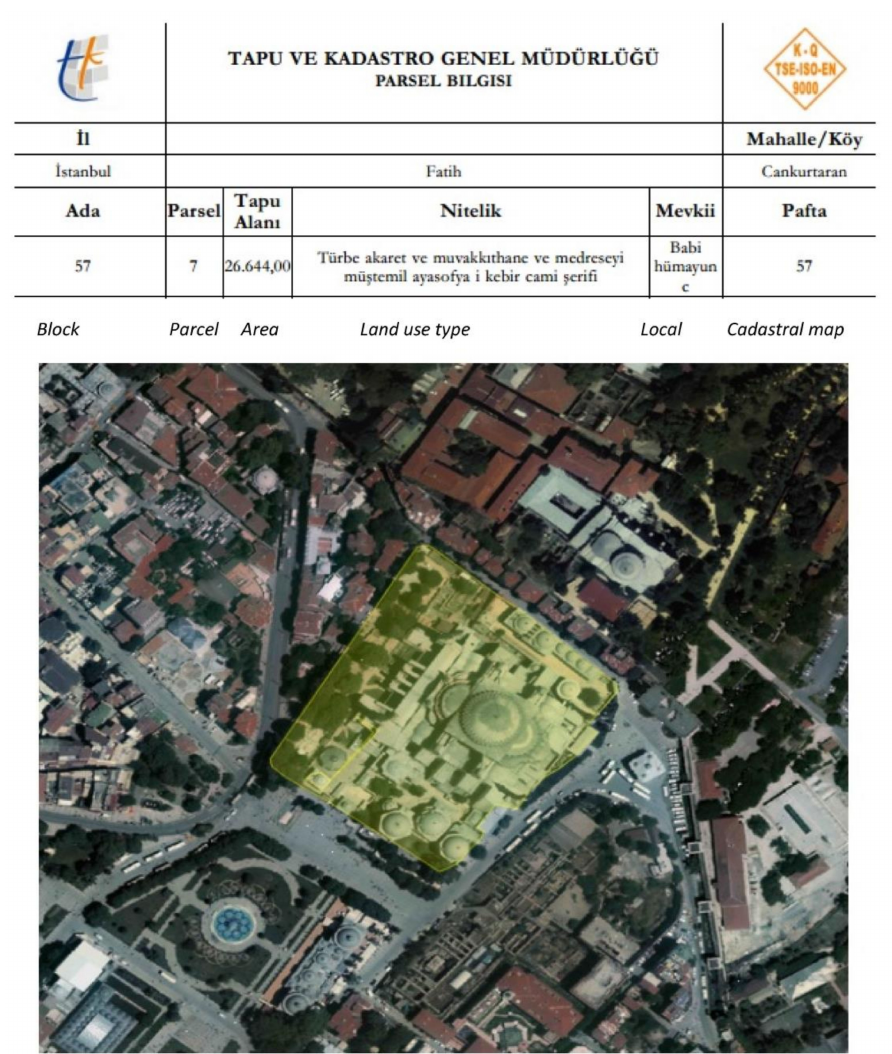
Figure 7. Screenshot of Hagia Sophia from the General Directorate of Land Registry and Cadastre (TKGM) [44].